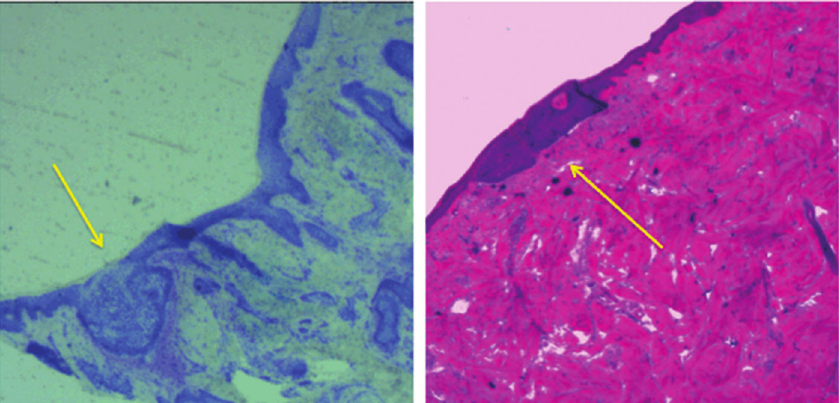
Figure 2 - Histological slides: Superficial basal cell carcinoma (yellow arrow). Left: toluidine blue stain. Right: hematoxylin and eosin stain.